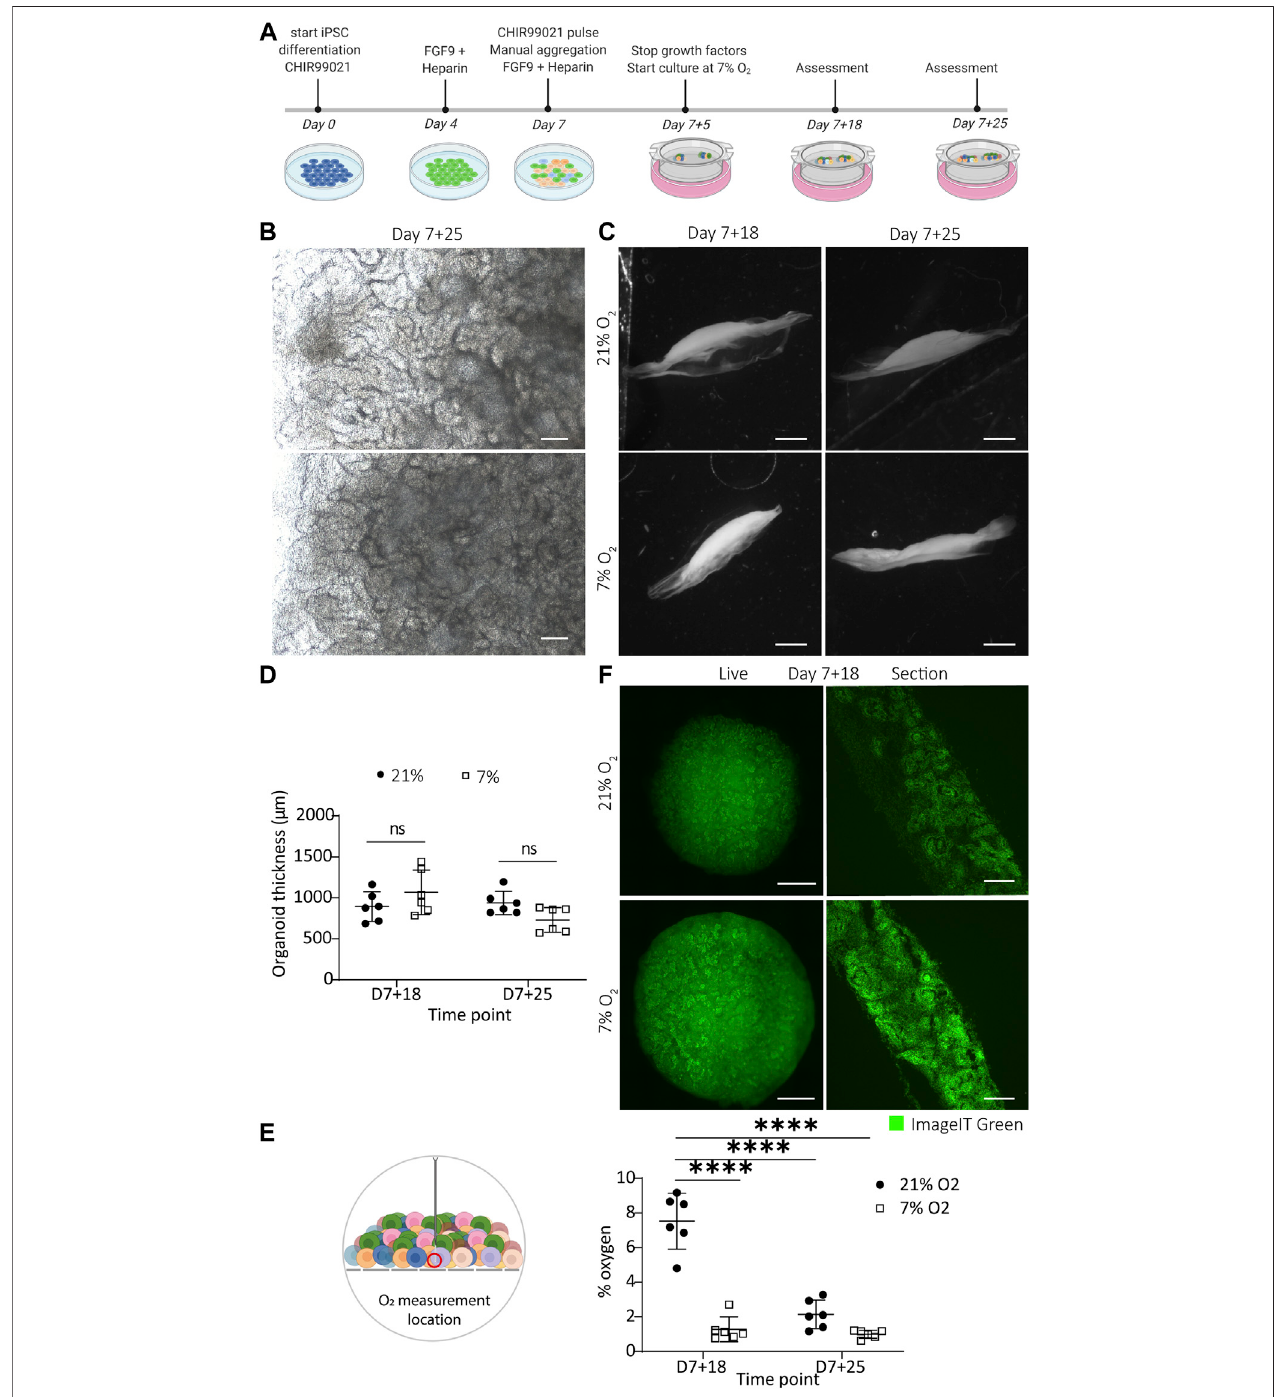
FIGURE 1 | Kidney organoids cultured in uterine-like hypoxic environment structurally form like their normoxic counterparts without the appearance of a hypoxic core. (A) . Schematic representation of the iPSC differentiation and organoid culture. Human iPSCs are differentiated for 7 days, after which aggregates are spotted on the air – liquid interface and cultured as organoids for up to 25 additional days (termed day 7 + 25). (B) . Bright fi eld images display comparable morphologies of the organoidscultured in7and 21%O 2 at theculture endpointday 7+ 25.Scale bar:200 µm. (C) .Dark fi eld images show thatthe macro-anatomyofthe organoids is comparable in both oxygen concentrations. Scale bar: 2 mm. (D) . Quanti fi cation oftheorganoid thickness from the dark fi eld images shows no difference between 21% O 2 and 7% O 2 . ( n = 2, N = 3). (E) . Oxygen measurement in the bottom part of the organoids towards the transwell fi lter shows that organoids in 7% oxygen have a comparableoxygenconcentrationtotheirnormoxiccounterpartsatday7+25,whichissigni fi cantlylowercomparedtothenormoxicconditionatday7+18.( n =2, N = 3; **** = p ≤ 0.0001) (F) . Organoids (left column) and cryosections of their central core (right column) stained on day 7 + 18 with the hypoxia dye ImageIT Green that produces a fl uorescent signal below 5% O 2 . The organoids display no hypoxic core but the dye stains all nephrons. Scale bar “ live ” : 1 mm, scale bar “ section ” : 100 µm.